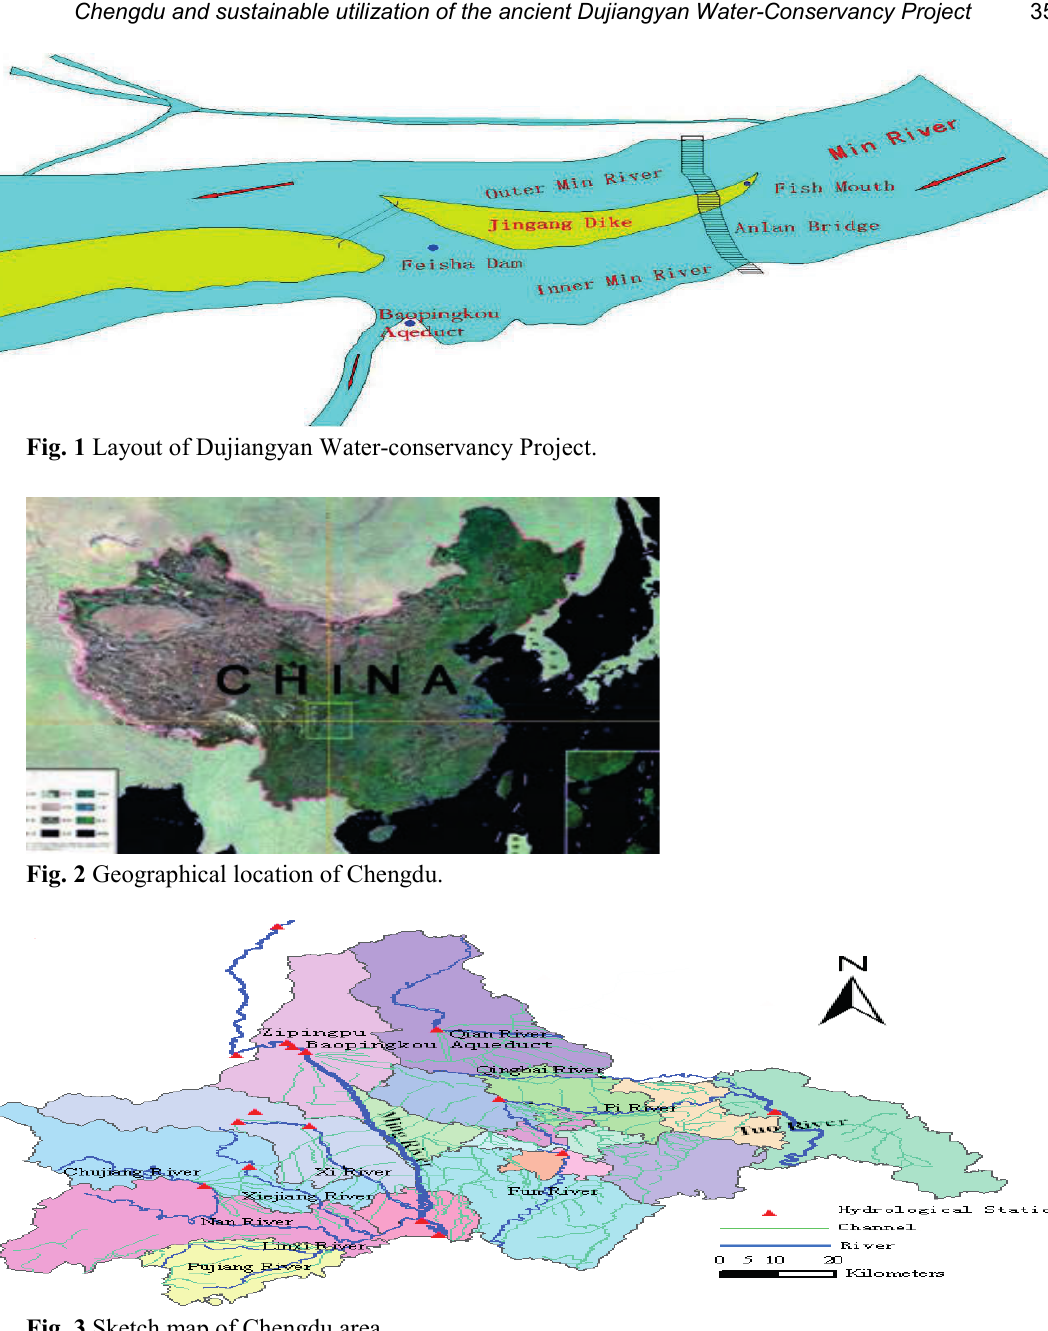
Fig. 3 Sketch map of Chengdu